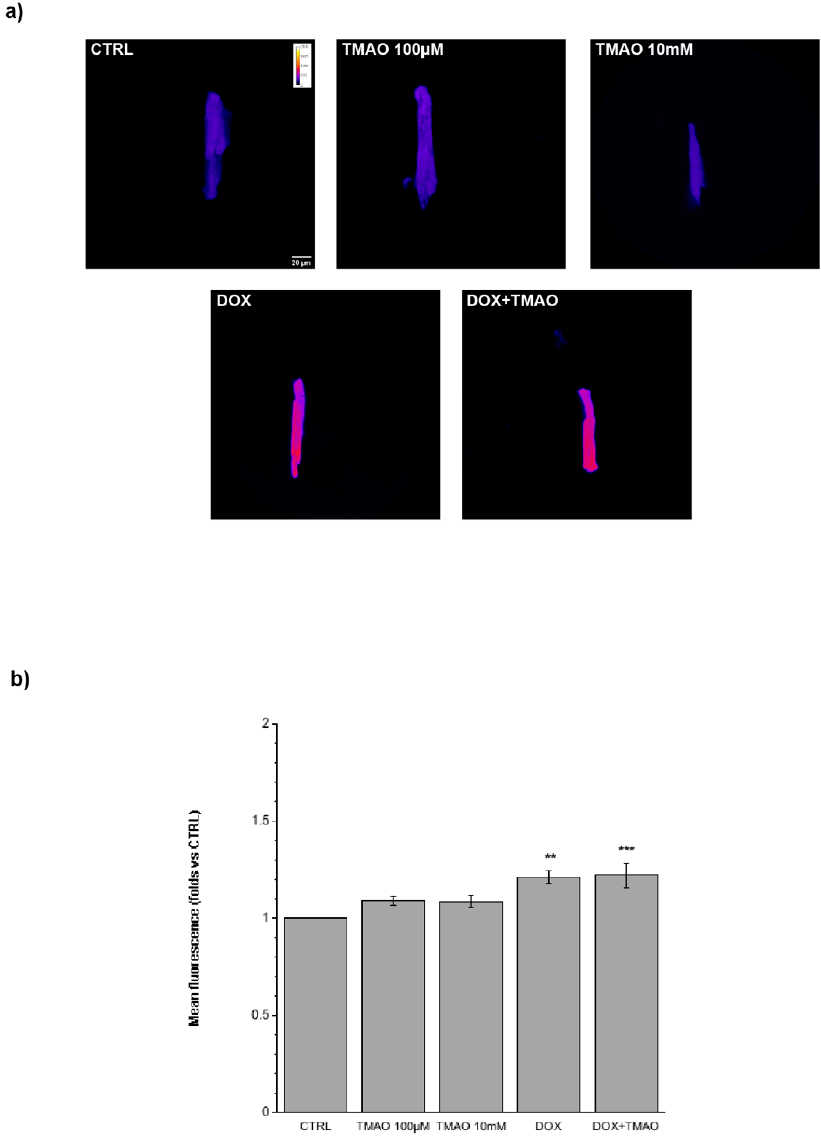
Figure 4. ROS production after 24 h of treatment. ( a ) Confocal microscopy images of cells treated with TMAO 100 µM and TMAO 10 mM for 24 h and labeled with the DCF-DA probe. In these experiments, doxorubicin (DOX) is used as a positive control (60× magnification). ( b ) Bar graph showing